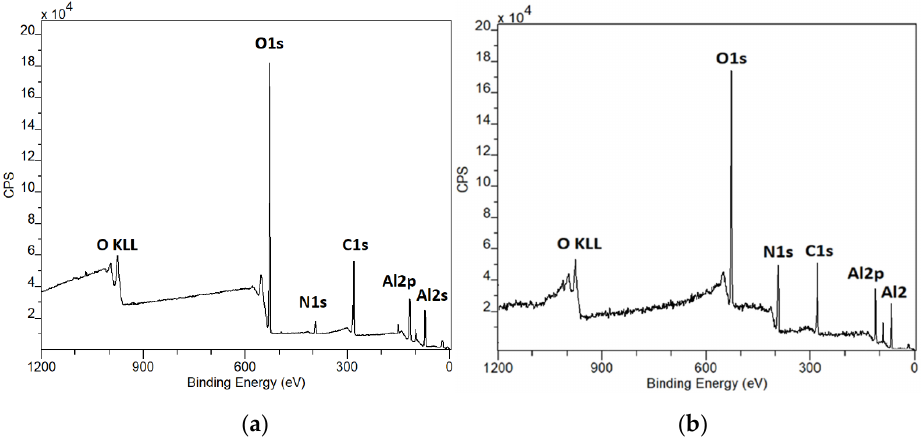
Figure 6. Comparison of XPS wide spectra of: ( a ) as-deposited AlN sample; ( b ) annealed AlN sample.